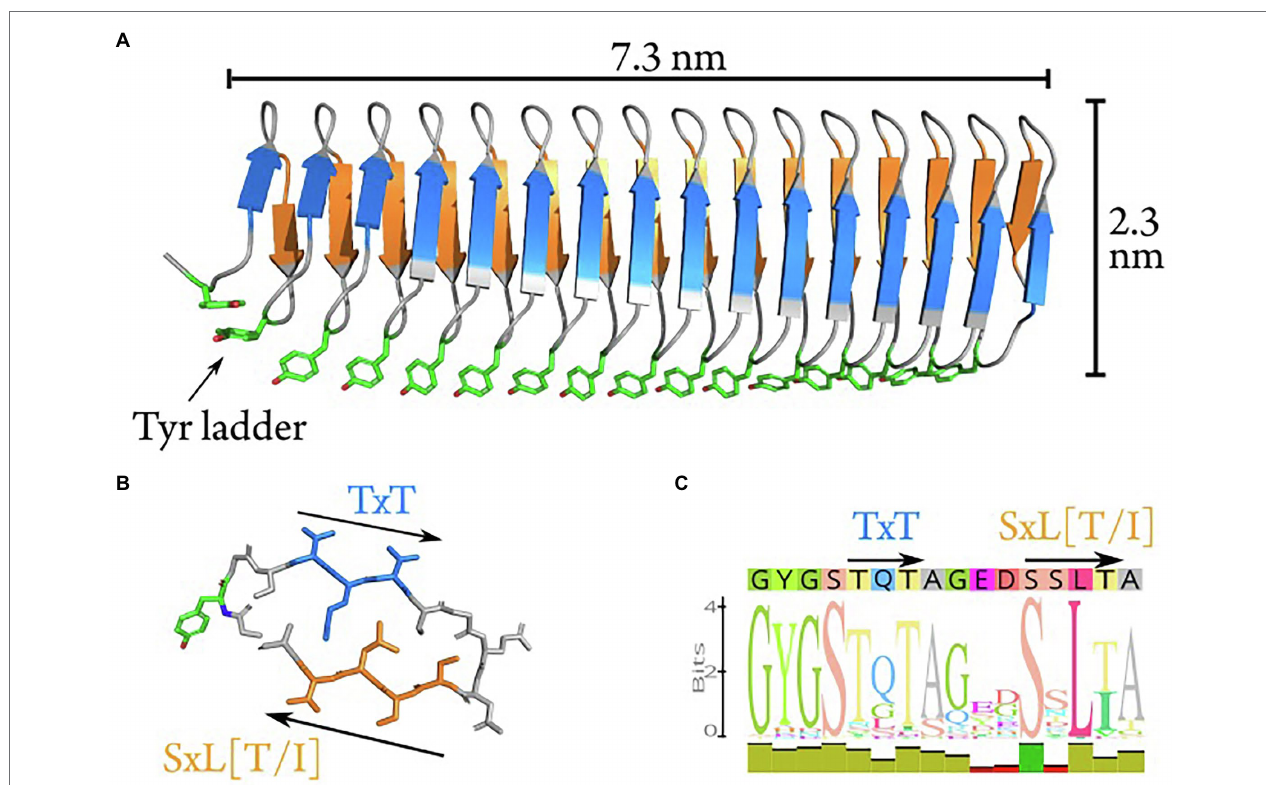
FIGURE 2 | Ab initio model of the first 16 repeats of the INpro CRD. (A) The ab initio model predicted using machine-learning-based algorithms in AlphaFold. The model consists of a β -helix with one extended β -sheet on each side. The β -strands have a rotation along the longitudinal axis of approximately 40 degrees when comparing N- to C-terminal. The highly conserved tyrosine ladder (annotated) is solvent-exposed along the side (shown with stick-representation). (B) Stick representation of repeat 13 which displays the best match to the consensus sequence (shown in C ). The two putative ice-nucleation active sites are annotated as TxT and SxL[T/I], respectively. (C) The consensus sequence of the INpro CRD. The predicted structural features are annotated above the sequence corresponding to the color scheme in (A) and (B) .